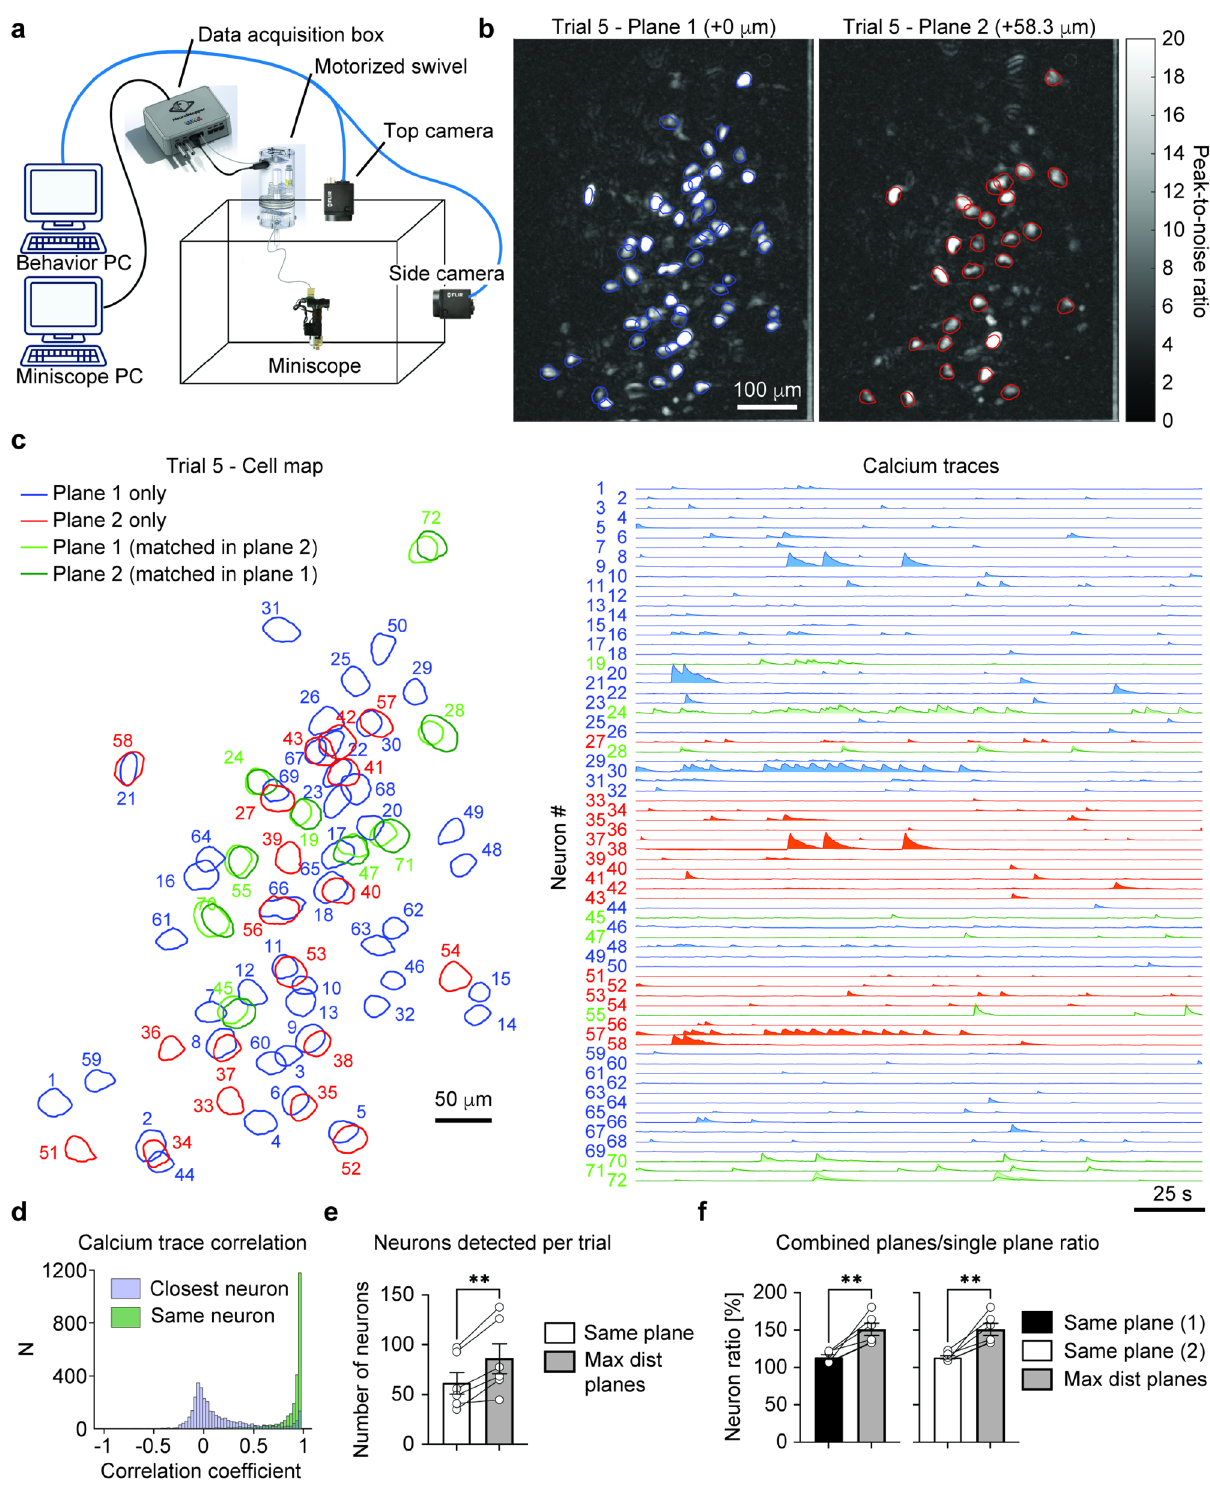
Figure 4. In vivo imaging of mPFC neurons expressing GCaMP7. ( a ) Scheme of the setup used for the open field recordings. ( b ) Peak-to-noise ratio for Plane 1 (left) and Plane 2 (right) in a representative trial with focal length difference of 58.3 μm. ( c ) Left: footprints of the neurons identified in the same trial shown in ( b ), highlighting neurons detected only on plane 1 (blue), only on plane 2 (red) and on both planes (light green for neurons detected in Plane 1 with a matching neuron on Plane 2, and dark green for neurons detected in Plane 2 with a matching neuron on Plane 1). Right: associated neural traces. ( d ) Histogram of the correlation coefficient for single trial calcium traces of neurons registered as same in plane 1 and plane 2. ( e ) Number of neurons detected per trial in trials with no change in focal plane and trials with maximum distance between the two focal planes (two-tailed paired t-test, p = 0.0053, n = 6 mice). ( f ) Ratio of total neurons detected per trial (using the information from both planes) over the average neurons detected per plane in the same trial. Data is shown separately for same focal plane at offset = 0 μm (trials 2, 6 and 14, two-tailed paired t-test, p = 0.0069, n = 6 mice) and same focal plane at offset = 58.3 μm (trials 4, 8 and 15, two-tailed paired t-test, p = 0.0055, n = 6